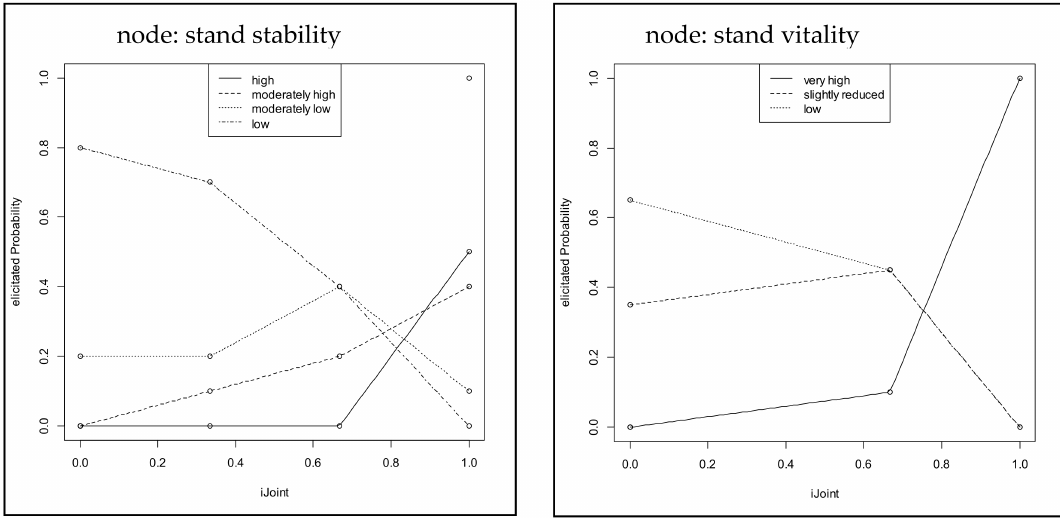
Figure 3. Conditional probability table (CPT) approximation graphs of two nodes of the bark beetle damage submodel (stand stability and stand